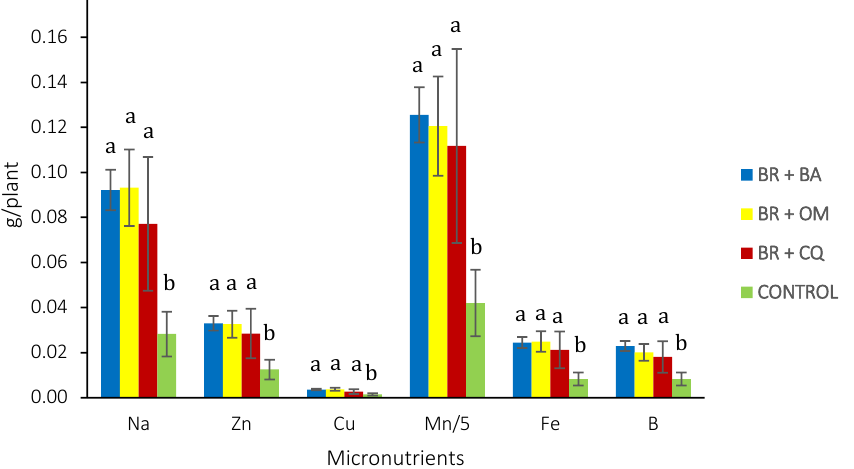
Figure 5. Micronutrients content of grains. Different letters mean statistically significant differences (value p ≤ 0.05) in LSD Test ( ± Standard deviation). (Mn/5): Mn value was divided by 5 so that they could be included with the rest of the data in the same